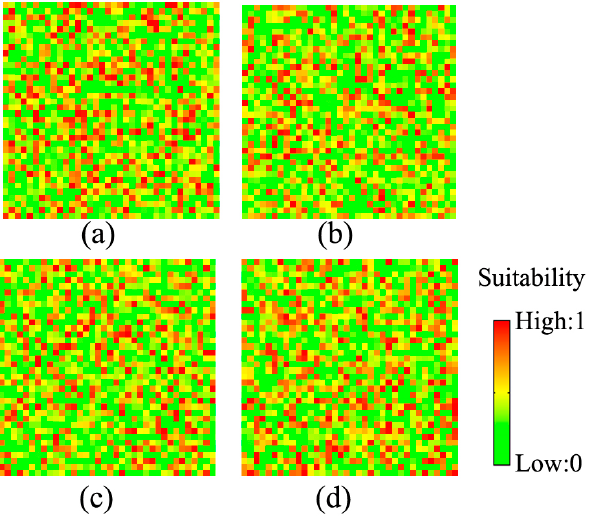
Figure 6. Suitability for 4 types of land-use in the hypothetical experiment (adapted from [28]). (a) The suitability of Land-use type 1; (b) The suitability of Land-use type 2; (c) The suitability of Land-use type 3; (d) The suitability of Land-use type 4.